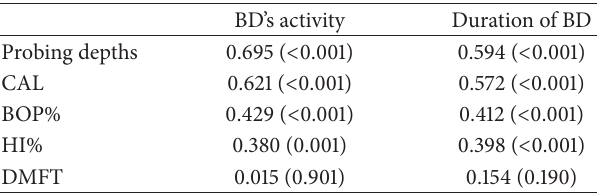
Table 2: Correlations of periodontal parameters with Behc¸et’s disease